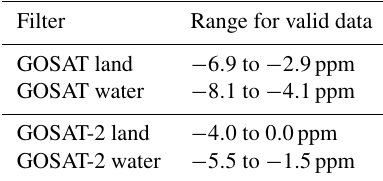
Table 9. Bias filter